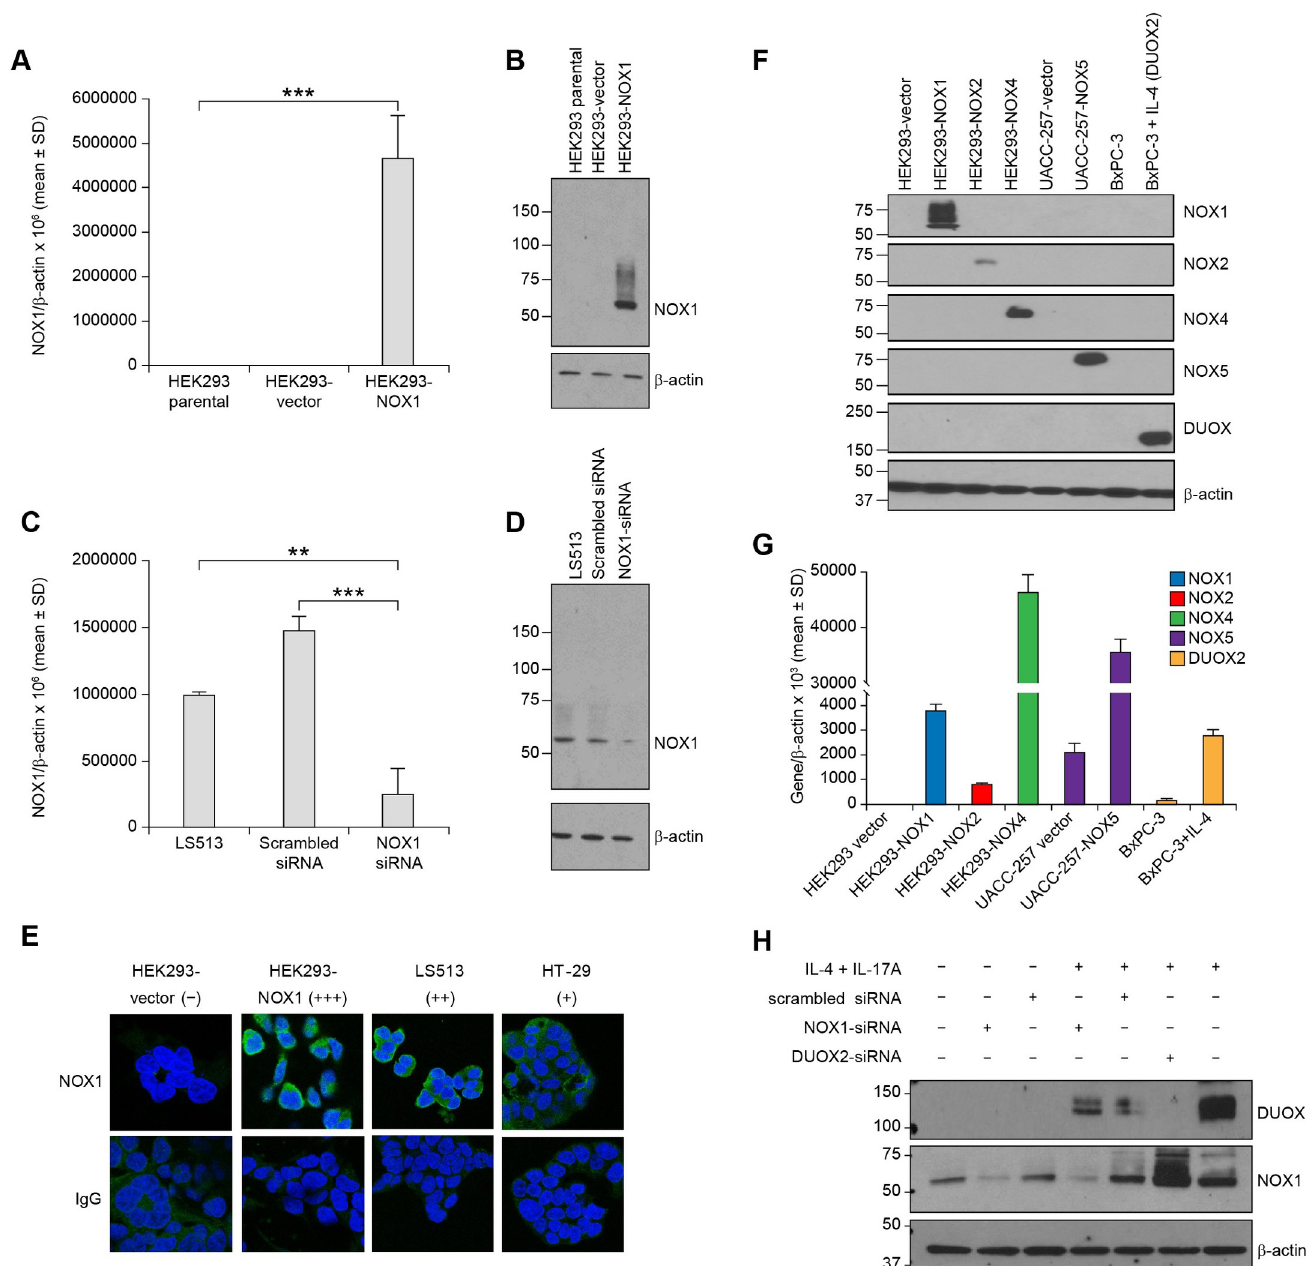
Fig 1. Characterization and validation of the novel NOX1 mouse monoclonal antibody. (A, B) HEK293 cells were stably transfected with the pCMV-NOX1 plasmid or an empty vector and selected with G418. NOX1 overexpression was confirmed (A) at the mRNA level by RT-PCR ( ��� p < 0.001 vs. untransfected cells), and (B) at the protein level by Western blot analysis. (C, D) Transient knockdown of NOX1 expression in the colon cancer cell line LS513 with a scrambled control or a NOX1-specific siRNA. (C) A 4-fold decrease in NOX1 expression compared to parental ( �� p < 0.01) and 6-fold decrease compared to cells transfected with scrambled siRNA ( ��� p < 0.001) was noted after 72 h at the mRNA level by RT-PCR. NOX1 mRNA level is given relative to β -actin. Data represent mean ± SD for at least 3 independent experiments. (D) Western blot analysis confirmed the NOX1 decrease at the protein level. (E) Immunodetection of NOX1 in HEK293-NOX1 and HEK293-vector control, LS513, and HT-29 cells by confocal microscopy. The cells were immunostained with NOX1 mouse mAb (green). Cell nuclei were stained with 4 0 ,6-diamidino-2-phenylindole (DAPI; blue), and mouse anti-IgG was used as a negative control. Digital images were taken at 63X magnification. NOX1 protein expression is qualitatively labeled as -, no expression; +, relatively low expression; ++, relatively higher expression; +++, highest expression. (F) To demonstrate a lack of cross-reactivity of the NOX1 antibody with other NOX isoforms, protein levels were measured by Western blot analysis for HEK293 cells stably transfected with the pCMV-NOX1 plasmid, the Myc-DDK-tagged-NOX2 plasmid, the pCMV-MycDDK-HsNOX4 plasmid, or an empty vector; UACC- 257-vector and UACC-257-NOX5 stable overexpressing clones; and BxPC-3 cells with or without IL-4 stimulation (25 ng/ml for 24 h). The antibodies used to detect